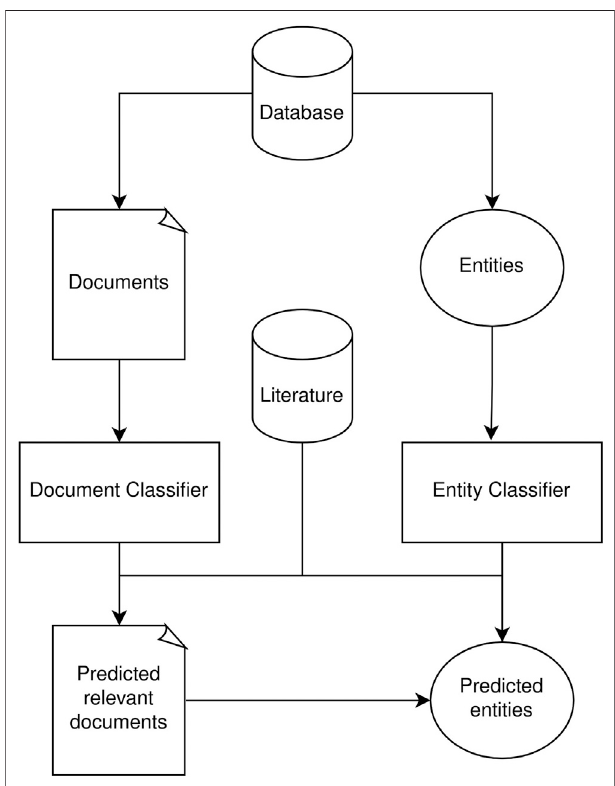
FIGURE 1 | Diagram of the Information Retrieval work fl ow for database curation. Using existing curated information from a database, it is possible to train both document and entity classi fi ers. These classi fi ers can then generate new candidate entries based existing